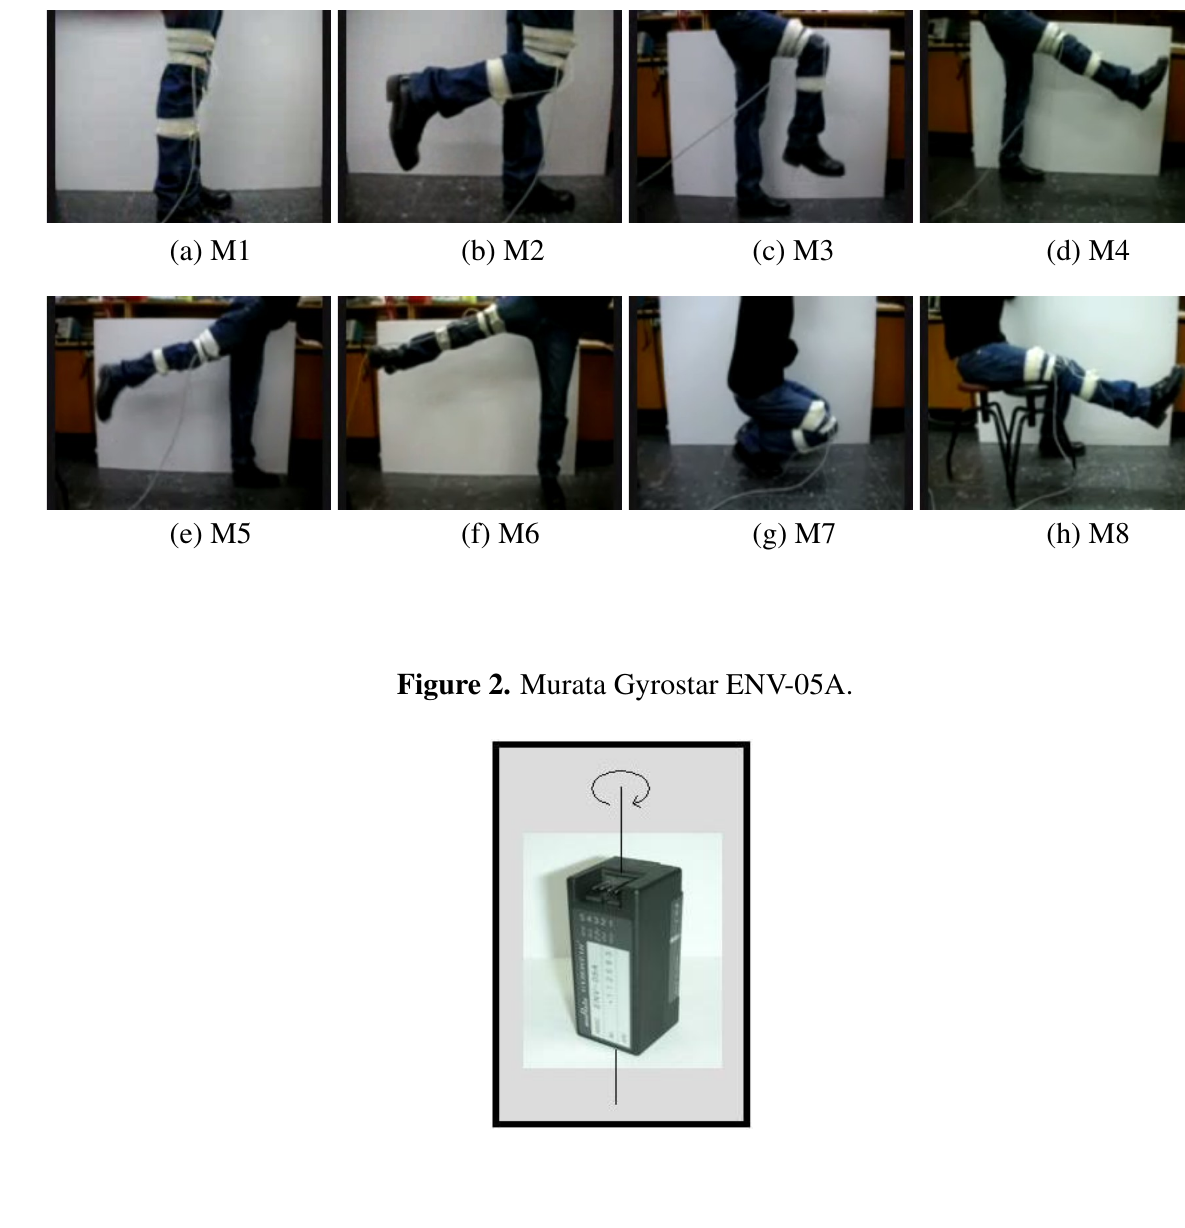
Figure 1. Eight different leg motions.